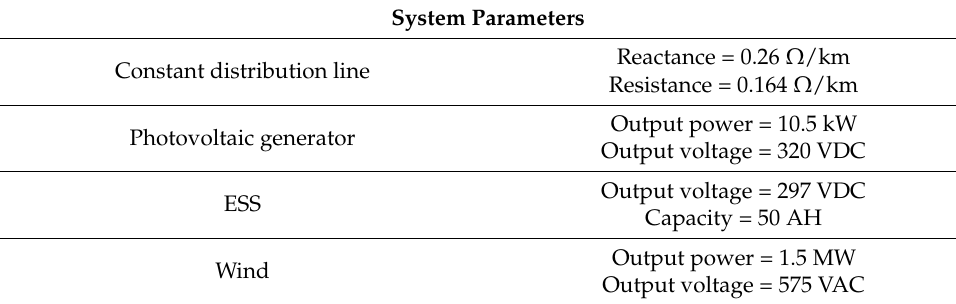
Table 1. Proposed test system